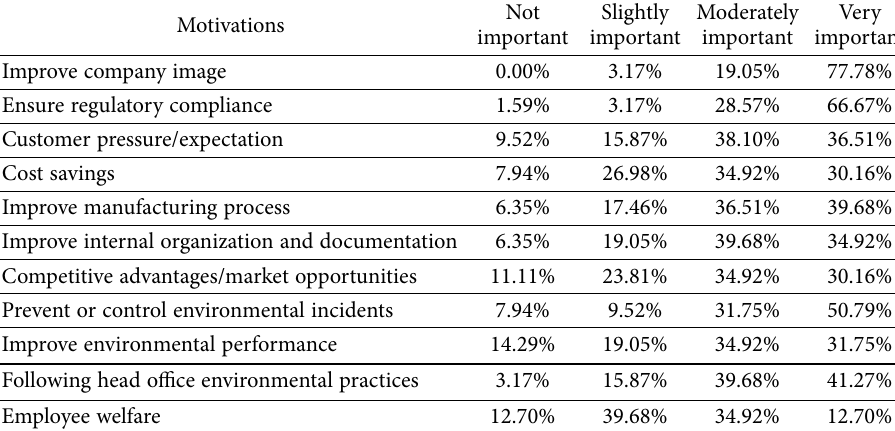
Table 2. Motives to undertake environmental practices in the company